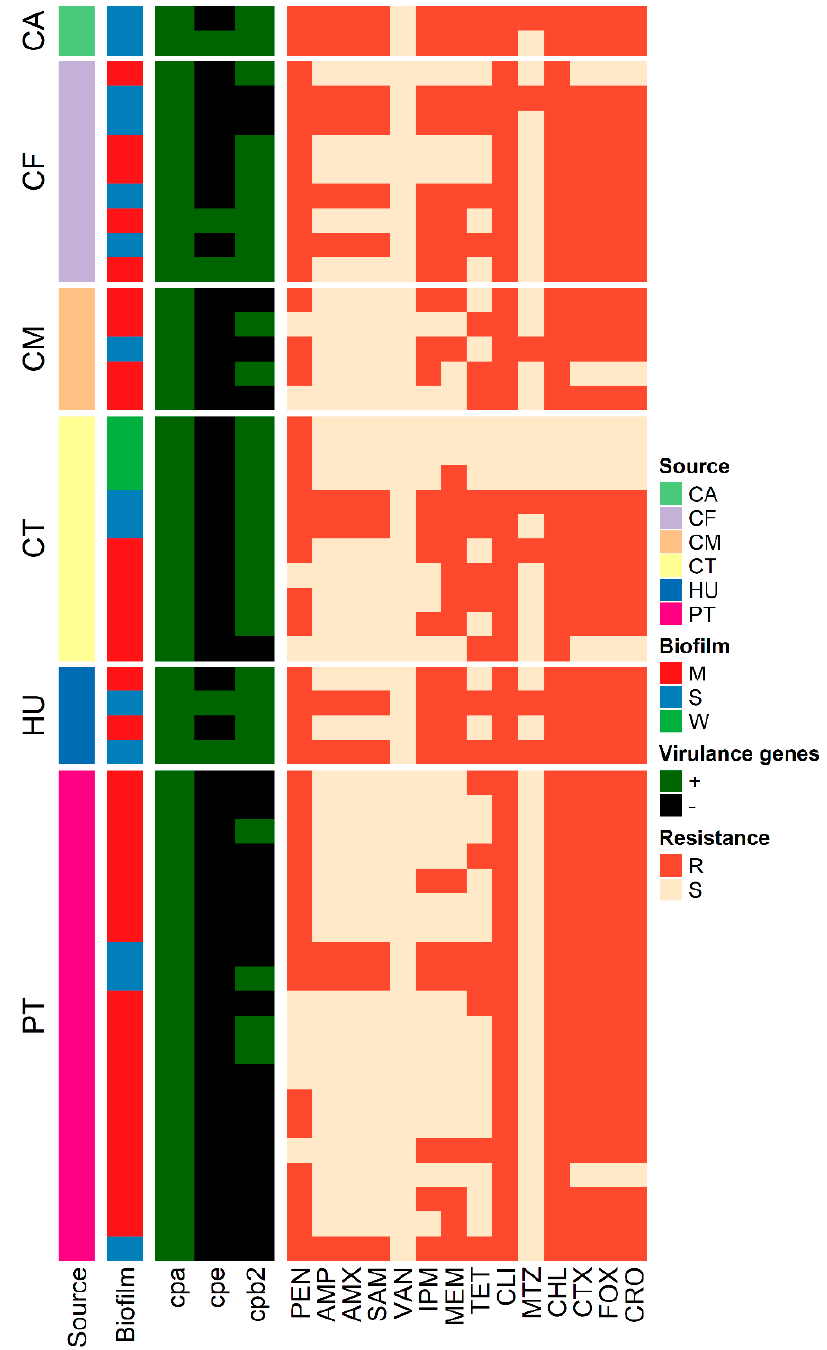
Figure 2. Heat map representation of virulence, biofilm, and antimicrobial resistance profiles of C. perfringens isolates recovered from chicken, pigeon, camels, and human consumers. CT: chicken intestine, CM: chicken meat, PT: pigeon intestine, CF: camel feces, CA: camel meat, HU: human stool, M: moderate, S: strong, W: weak, MAR: multiple antibiotic resistance. Penicillin (PEN), ampicillin (AMP), amoxicillin (AMX), ampicillin-sulbactam (SAM), clindamycin (CLI), metronidazole (MTZ), imipenem (IPM), meropenem (MEM), chloramphenicol (CHL), tetracycline (TET), cefotaxime (CTX), cefoxitin (FOX), and ceftriaxone (CRO). R: resistant, S: sensitive.